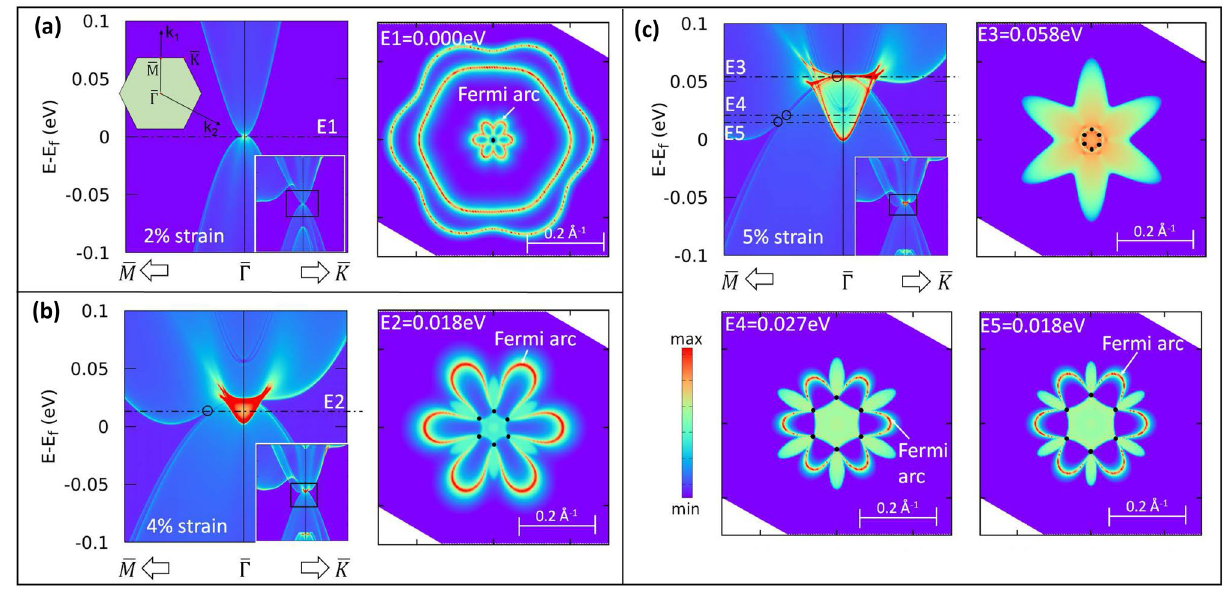
Figure 5. Electronic structure of semi-infinite slabs of YPdBi under ( a ) 2% ( b ) 4% and ( c ) 5% tensile strains. Inset in ( a ) shows 2D BZ of the semi-infinite slab with high symmetry